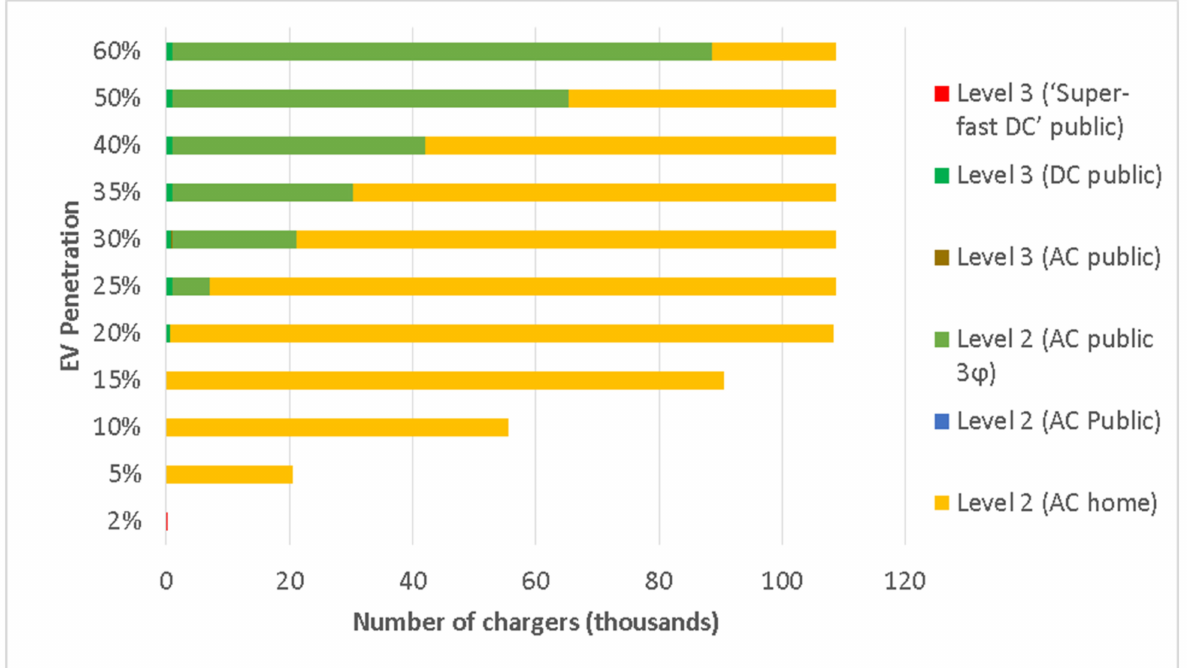
Figure 12. Number of each type of EV chargers installed for each ratio of EV